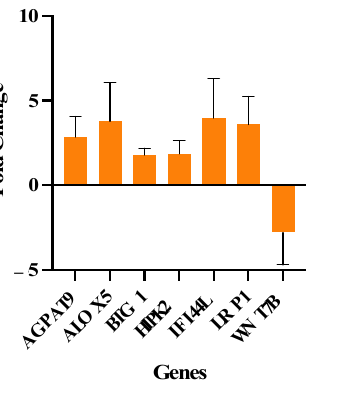
Figure 7. Investigation of doxorubicin synergy. ( A ) The mechanism of action for doxorubicin induced cytotoxicity is mainly through inhibition of topoisomerase II or induction of double strand breaks or reactive oxygen species (ROS). ( B ) Upon DSB formation, an H2B variant, H2AX, gets phosphorylated ( γ H2AX, yellow circle), which is a hallmark of DSBs. (The blue cyclinder represents the histone octomer.) Quantification of DNA DSBs as monitored by flow cytometry of γ H2AX activation upon treatment of THP-1 cells with iDual (5 µ M, 72 h) and doxorubicin (DOX, 62.5 nM, 48 h). ( C ) ROS levels of THP-1 cells with iDual, (5 µ M, 72 h) and doxorubicin (62.5 nM, 24 h). Generation of oxidative stress was assessed by flow cytometry. ( D ) Expression levels of DNA damage repair genes from five pathways (BER: base excision repair; NER, nucleotide excision repair; HDR, homology directed repair; NHEJ, non-homologous ends joining; MMR, mismatch repair) upon treatment of THP-1 cells with iDual (5 µ M, 72 h). ( E ) Doxorubicin is a substrate of ABC transporters (ATP pump, represented in pink), which can efficiently efflux drugs outside the cell, reducing their toxicity. RT-qPCR analysis showing expression levels of different ABC genes upon iDual (5 µ M, 72 h) in THP-1 cells. Expression levels of sensitizer genes after iDual (5 µ M, 72 h) via qPCR analysis in THP-1 cells ( F ). Relative RTq-PCR target gene expressions were determined by the 2 ( − ∆∆ CT) method. Data were represented as the average of ± standard error of the mean of two biological repeats with duplicates. (* p < 0.05, ** p < 0.01 and *** p < 0.001, student’s t -test). Schematic illustrations were generated in BioRender.com.